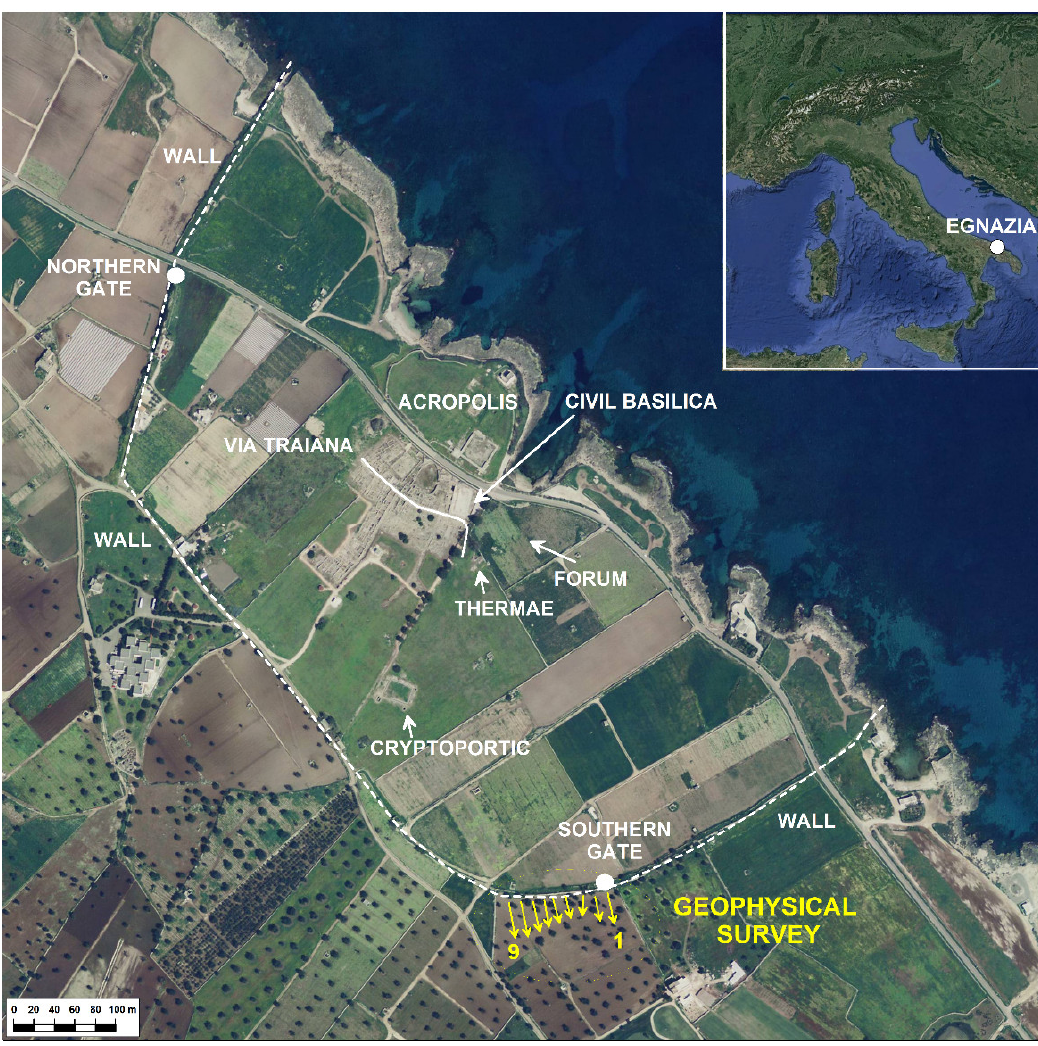
Figure 1. Survey plan on a 2008 TerraItaly™ Orthophoto with indication of the 1–9 parallel 2D Electrical Resistivity Tomography (ERT) lines (in yellow).